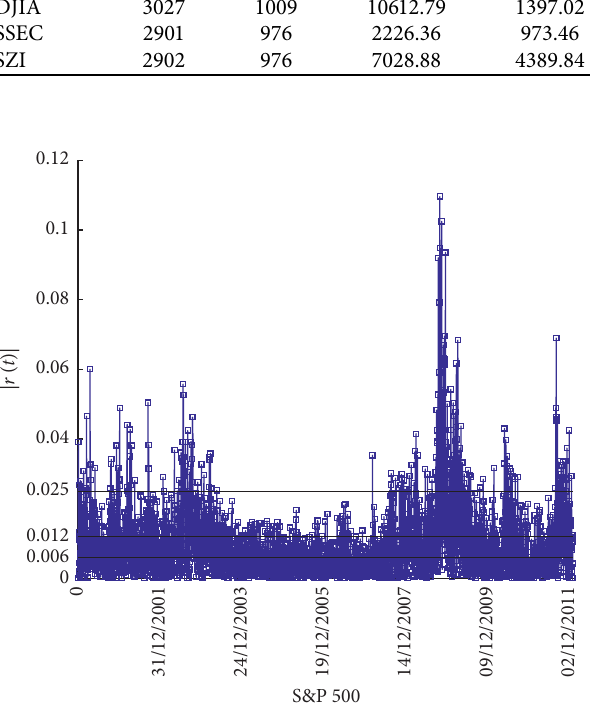
Figure 3: Absolute returns of S&P 500 with different